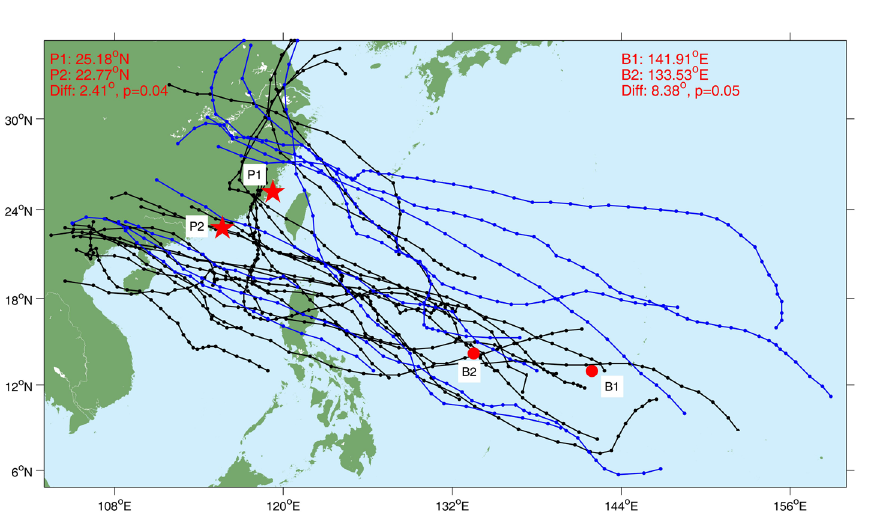
Figure 6. Typhoon paths of the annual strongest typhoons in El Niño (blue) and non-El Niño (black) years during 1987–2016. B1 and B2 (P1 and P2) represent the average genesis (landfall) positions of these typhoons in El Niño and non-El Niño years, respectively. Figures were plotted using MATLAB R2018b (http:// www. mathw orks.